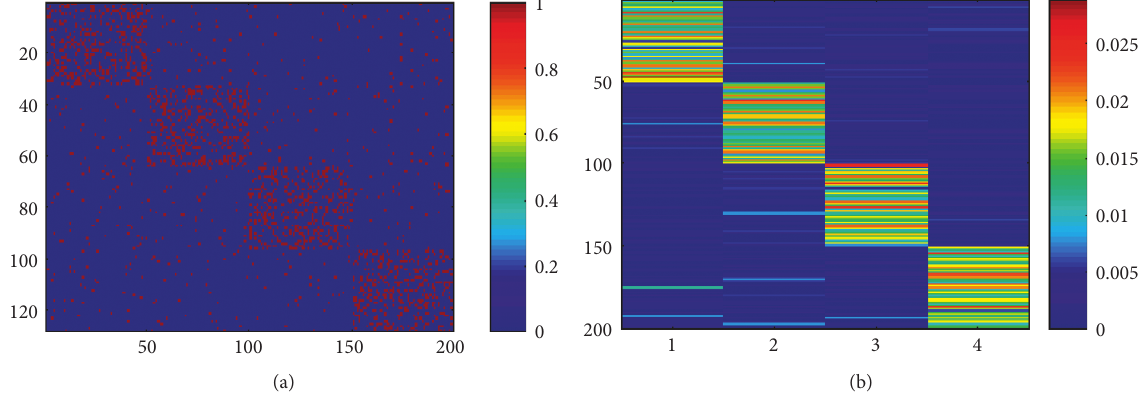
Figure 3: (a) The node attributes’ matrix. (b) The community attributes’ matrix.